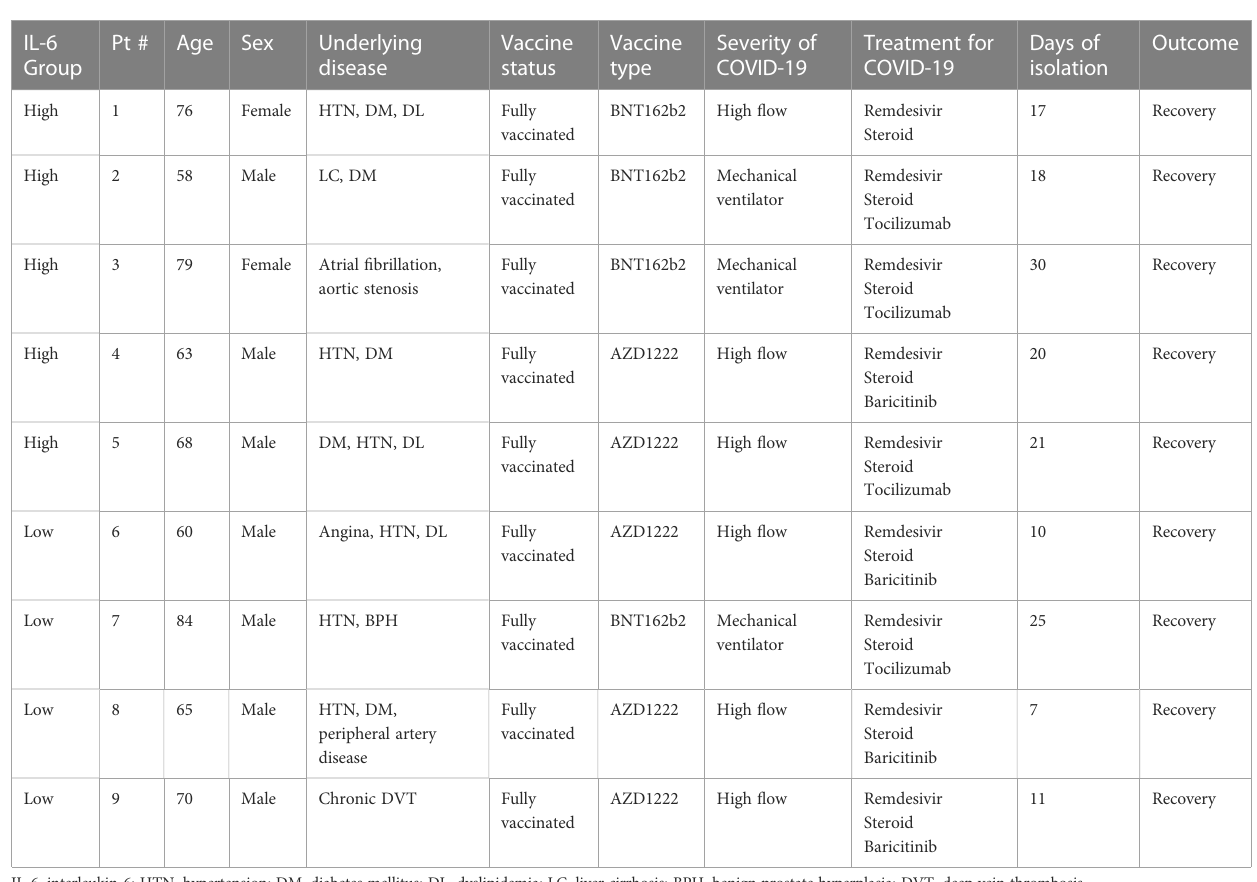
TABLE 1 Clinical information of study